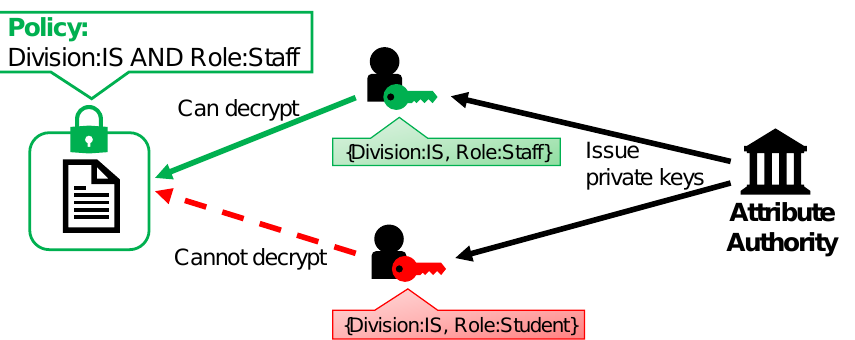
Figure 5. Example of access control to data using CP-ABE.